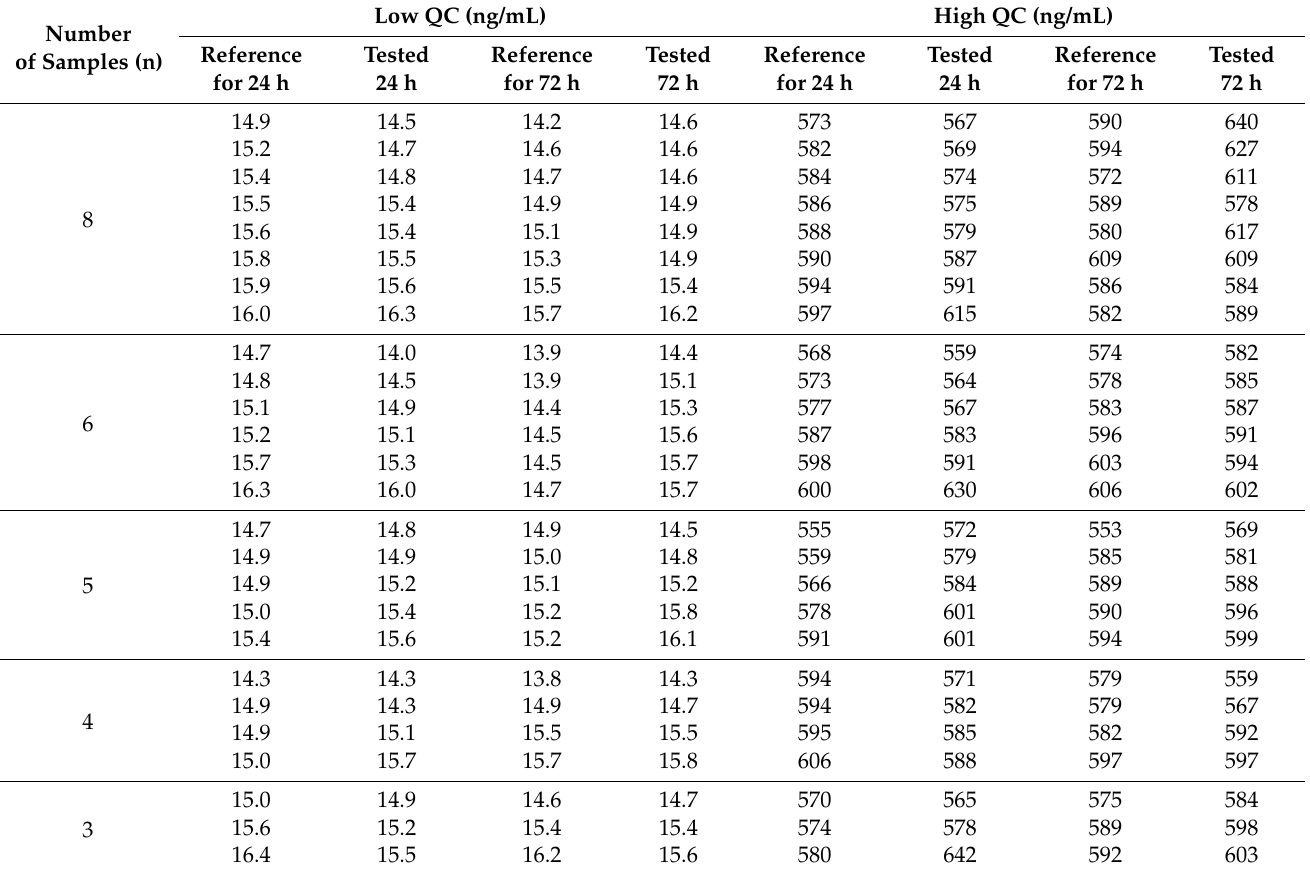
Table A1. Concentrations of tramadol in human plasma during stability testing after storage for 24 h and 72 h at room temperature—low QC (nominal concentration of 15.0 ng/mL) and high QC (nominal concentration of 600